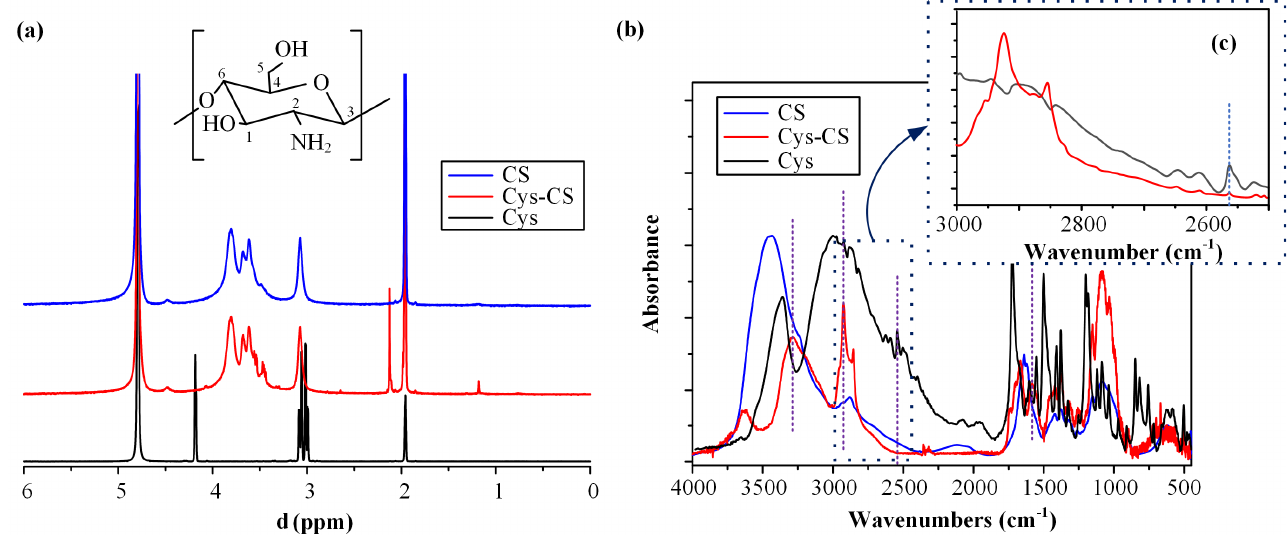
Figure 2. 1 H-NMR ( a ) and FTIR ( b ) spectra of the neat CS, the neat Cys and the conjugated Cys-CS. FTIR ( c ) spectra of the stretch vibration of the S–H